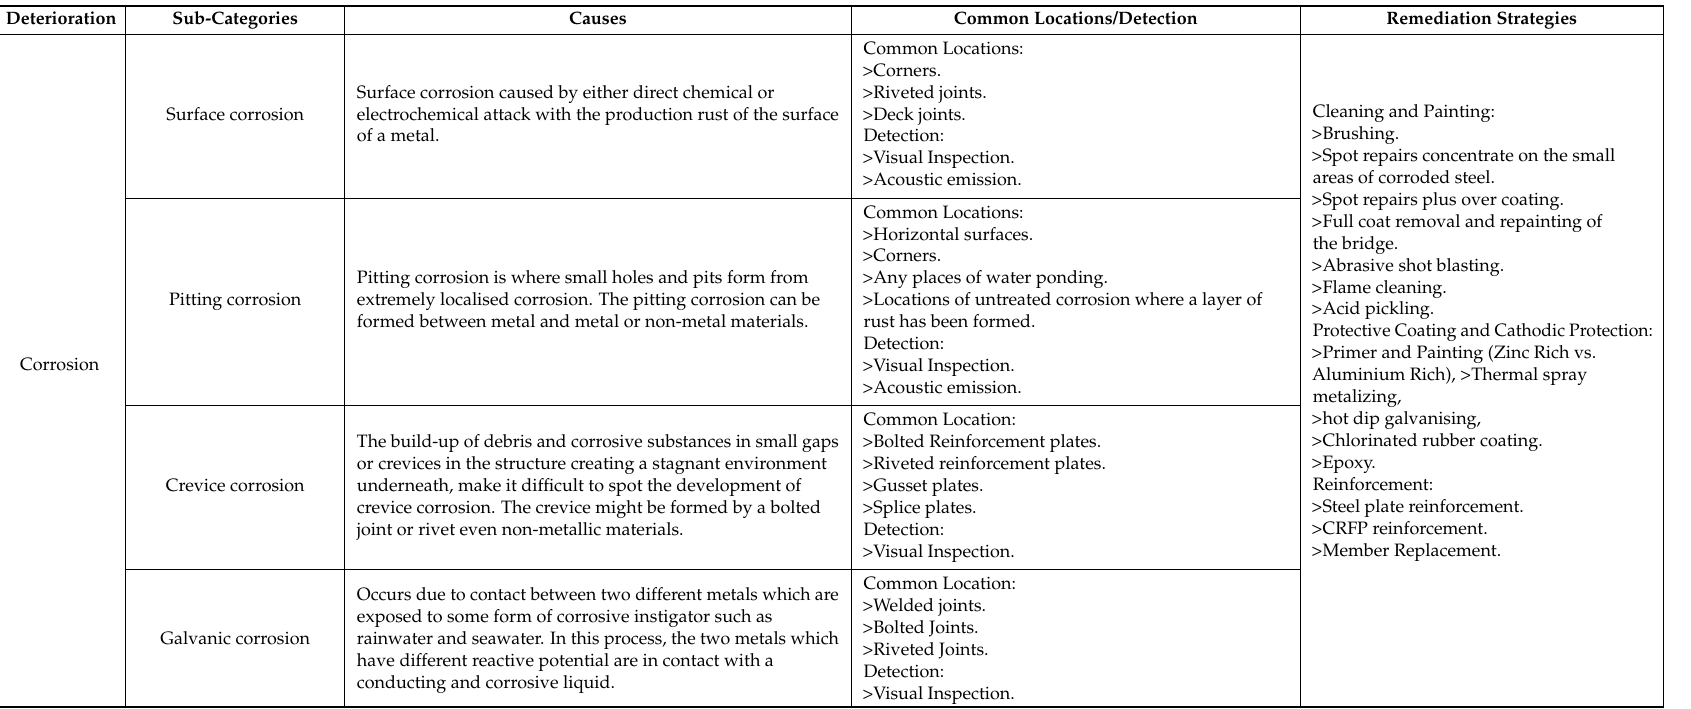
Table 2. Major Defects, Causes, Common Locations, Detection Methods and Remediation Strategies for Steel